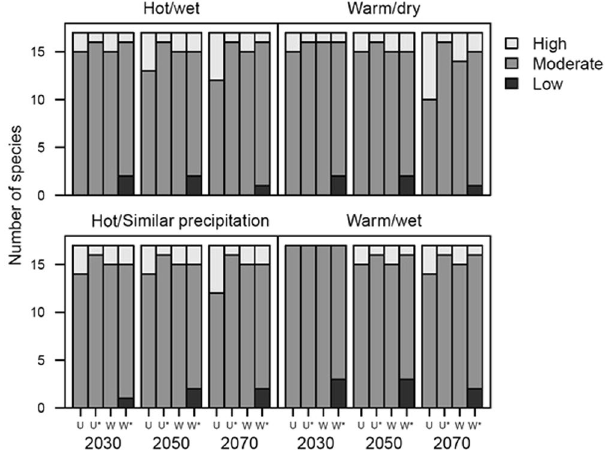
Figure 3. Number of species assigned to the three climate change vulnerability rankings for the 17 lizards, according to the unweighted (U) and weighted (W) scoring schemes. Asterisks ( * ) indicate analyses that considered all three elements of vulnerability: exposure, sensitivity and adaptive